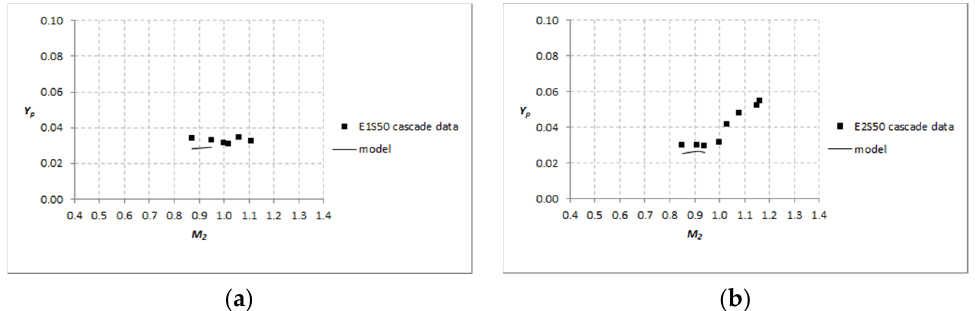
Figure 5. Comparison of simulated and experimental total pressure profile loss coefficient for ( a ) E1S50 cascade [25]; ( b ) E2S50 cascade [25].